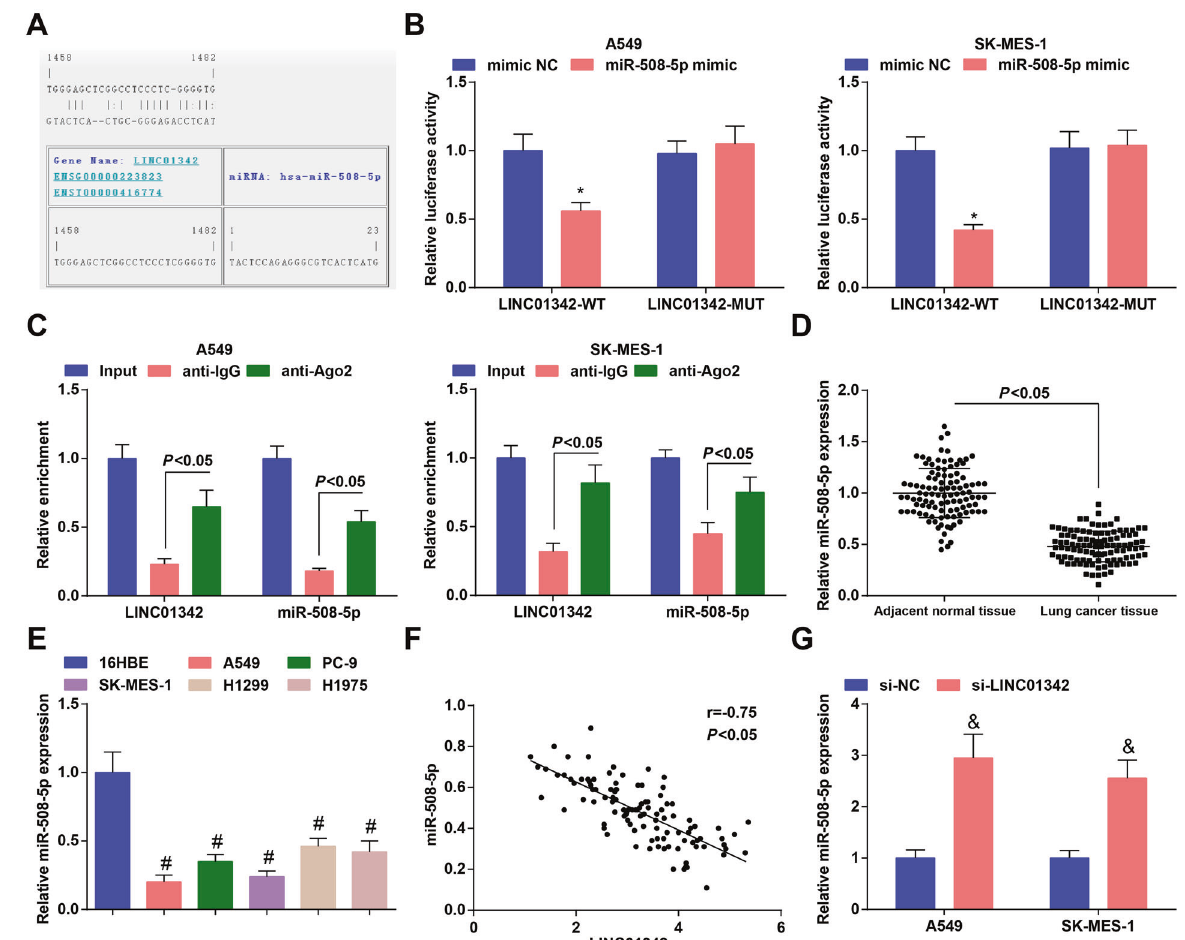
LINC01342 and miR-508-5p was detected using RIP assay. D miR-508-5p expression in LC tissues was determined using RT-qPCR. E miR-508-5p expression in LC cells was determined using RT-qPCR. F correlation between expression of LINC01342 and miR-508-5p was analyzed using the Pearson test. G miR-508-5p expression after LINC01342 silencing was determined using RT-qPCR. * P < 0.05 vs. the mimic NC group; # P < 0.05 vs. 16HBE cells, & P < 0.05 vs. the si-NC